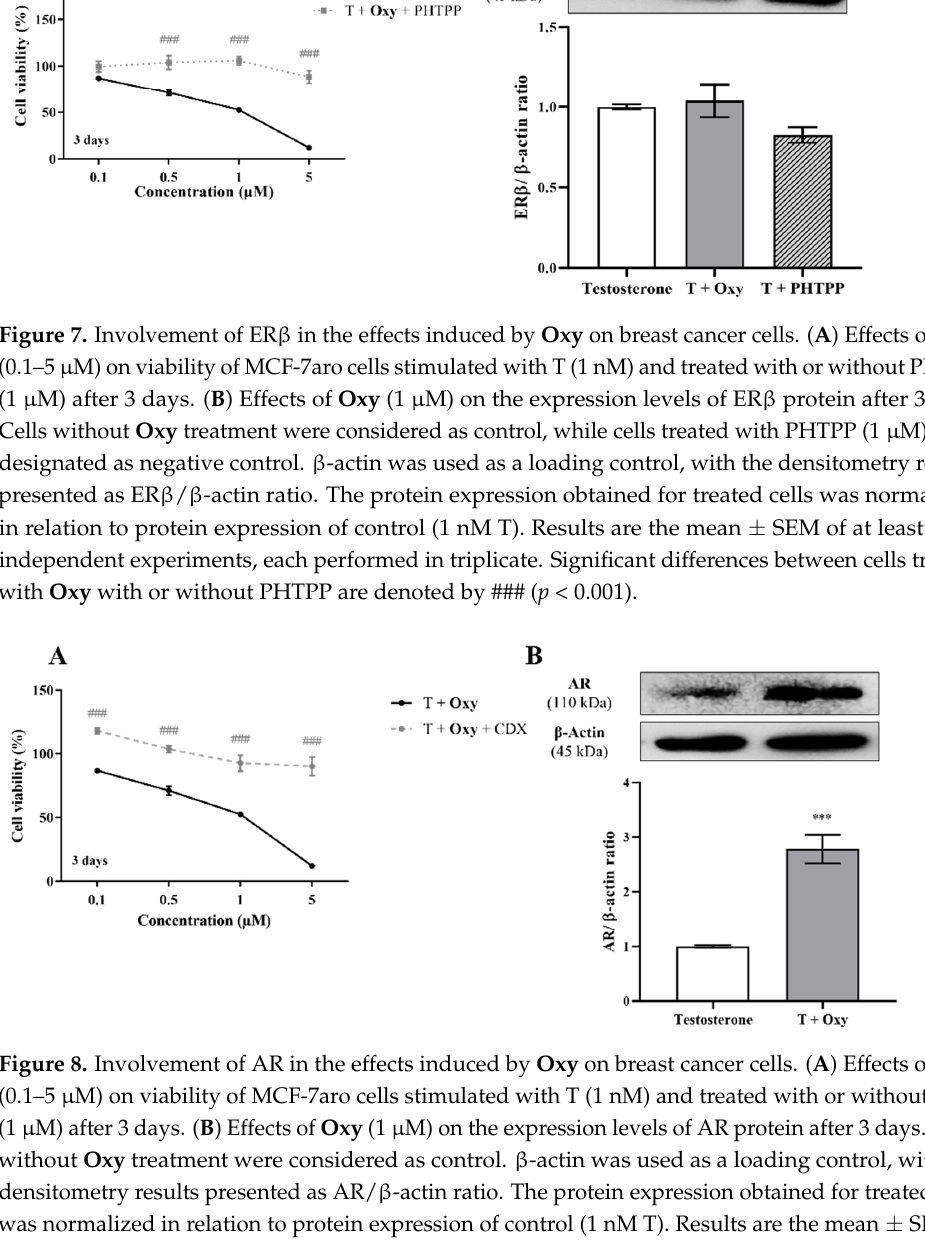
Figure 9. Effects of Oxy on viability and cell death of apoptosis of resistant breast cancer cells. ( A ) Effects of Oxy (0.1–2.5 μ M) on viability of LTEDaro cells after 3 and 6 days. ( B ) Effects of Oxy (1 μ M) on the activity of caspase ‐ 7 after 3 days of treatment. Cells without Oxy treatment were con ‐ sidered as control, while cells treated with STS (10 μ M) were used as positive control. Z ‐ VAD ‐ FMK was used as a pan ‐ caspase inhibitor. Cell viability effects of Ox y were normalized in relation to control (100% of cell viability). Results are the mean ± SEM of at least three independent experi ‐ ments, each performed in triplicate. For caspase activation assays, results are expressed as relative luminescence units (RLU). Significant differences between Ox y ‐ treated cells and the control are shown by *** ( p < 0.001), while differences between Oxy ‐ treated cells with or without Z ‐ VADFMK are indicated by δδδ ( p < 0.001).